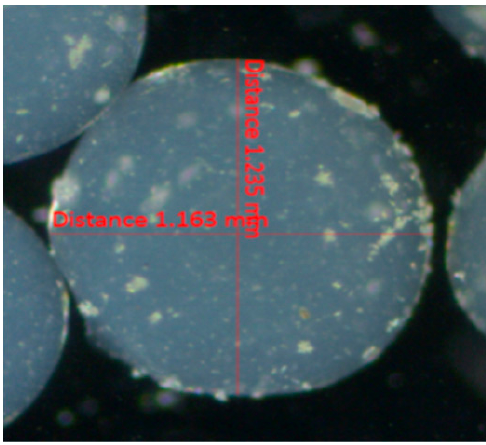
Figure A2. The regular spherical shape of alginate beads containing encapsulated fungal dextranase from P. roquefortii TISTR 3511 and diameter ( mm ).